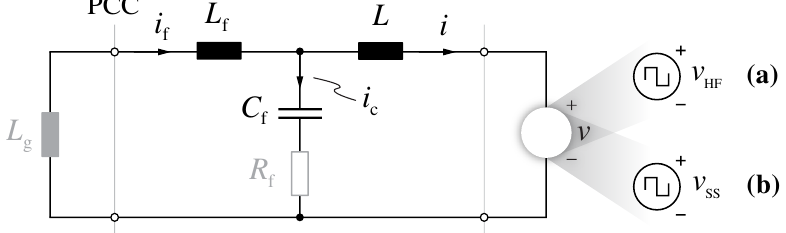
Figure 3. Single-phase equivalent circuit of the considered system, where the converter is represented by the voltage source v . The circuit is valid both from ( a ) a high-frequency harmonic perspective ( v = v HF ) and from ( b ) a small-signal (i.e., control) stand point ( v = v SS